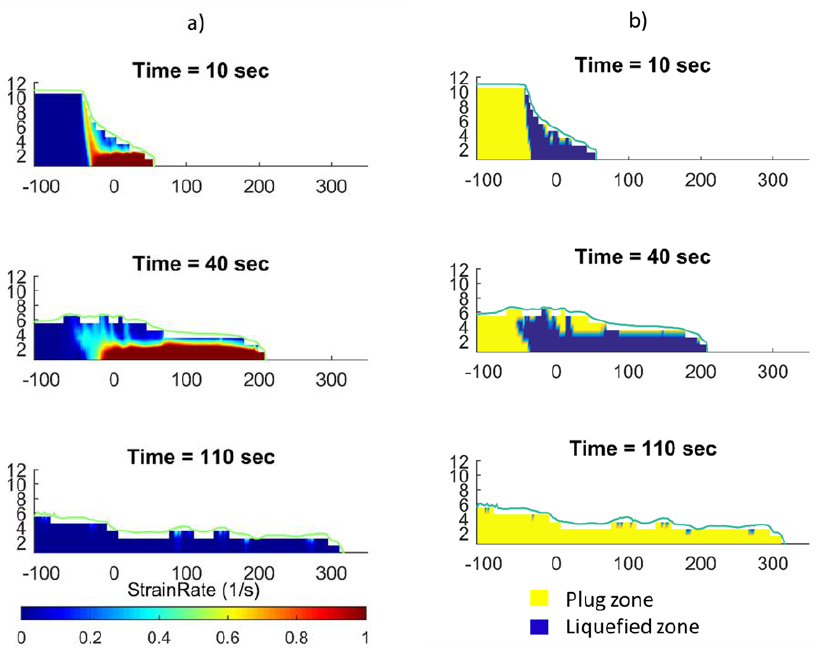
Figure 10. Snapshots on the centerline cross-section of the breach (y = 220 m) predicted by MBM. ( a ) The profiles of strain rate. The color bar is set from 0.0 to 1.0 s − 1 to emphasize the interface between the plug zone and liquefied zone at liquefied